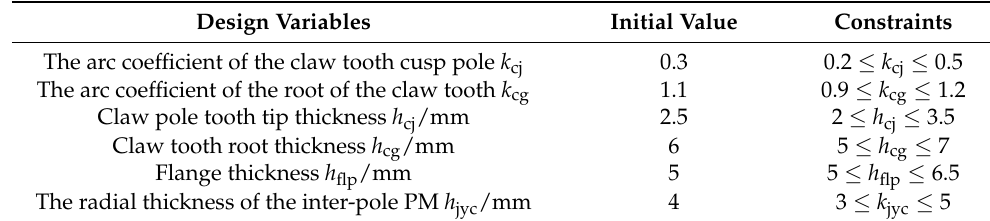
The radial thickness of the inter-pole PM h jyc /mm 3 ≤ k jyc ≤